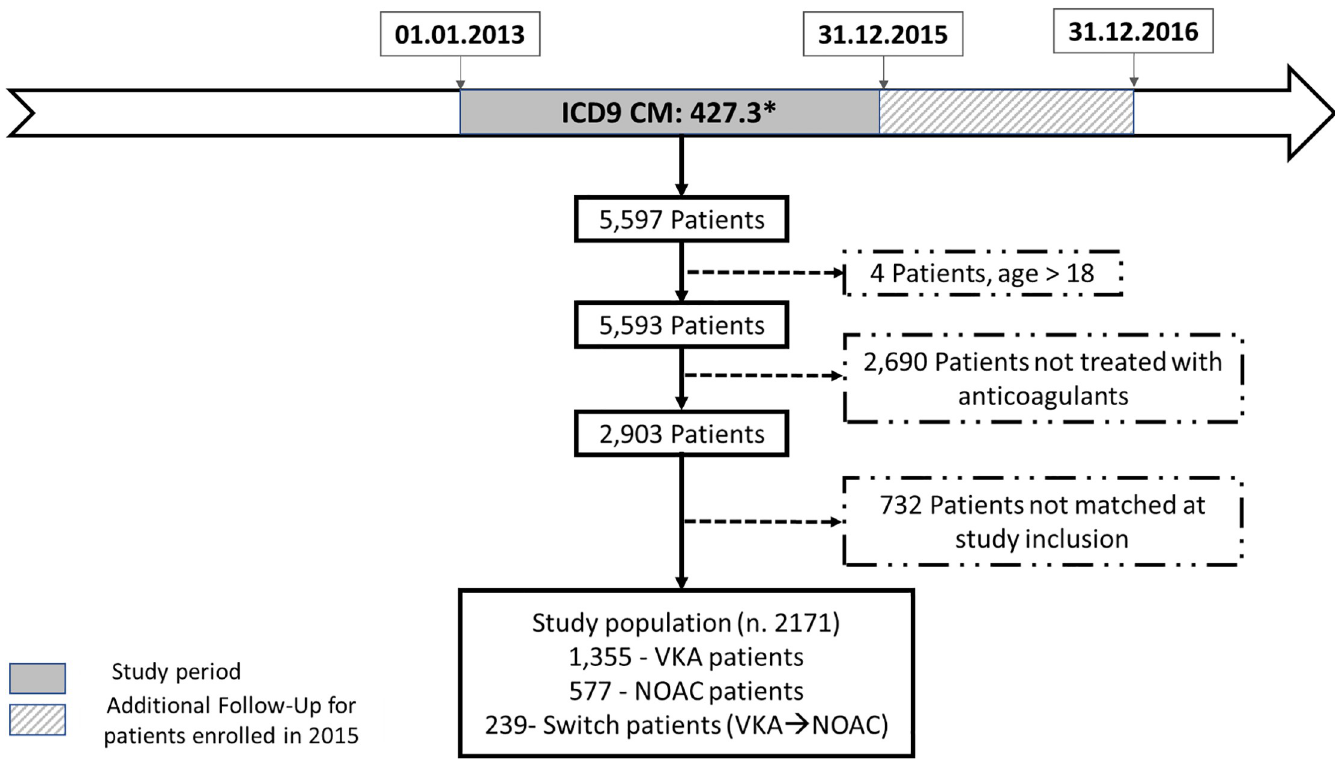
Fig 1. Flowchart showing selection of study